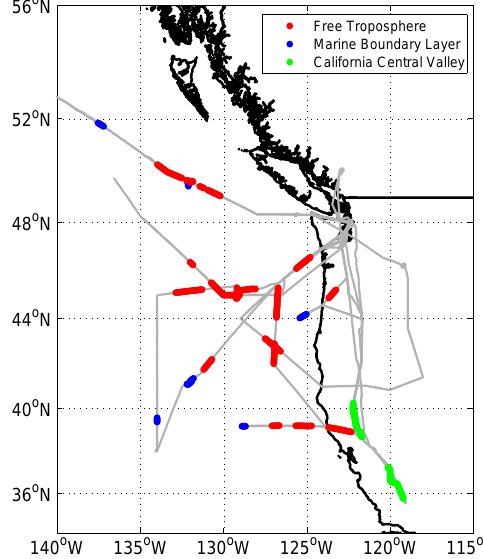
Fig. 1. Flight tracks for each level leg used in analysis. Tracks are color-coded by air mass category: free troposphere (red), marine boundary layer (blue), and continental boundary layer (green). Grey lines indicate entire flight tracks for each research flight included in this analysis.